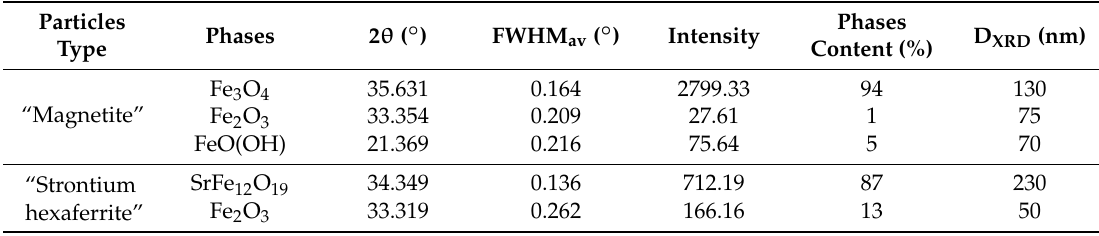
Table 2. Results of XRD analysis of the most intensive peaks for commercially available “magnetite” and “strontium hexaferrite”